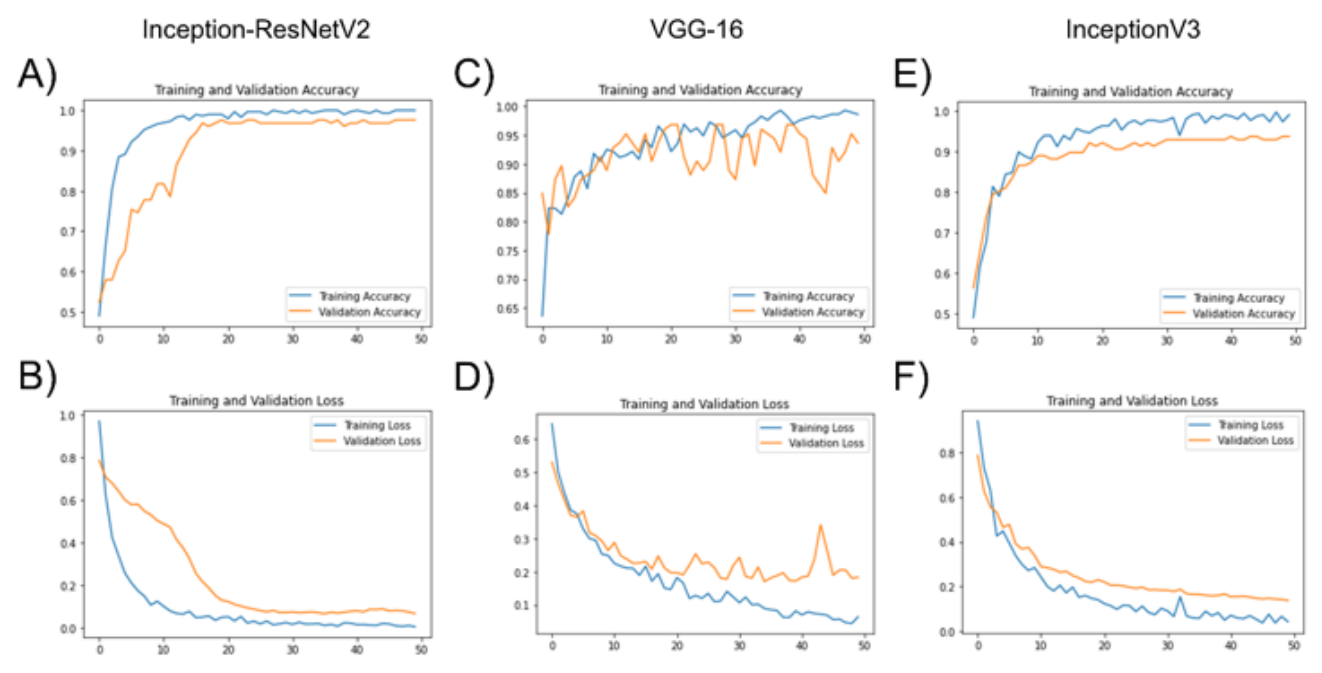
Figure 2. Training/validation accuracy ( A , C , E ) and training/validation loss ( B , D , F ) plots for the fine ‐ tuning for the ImageNet pretrained Inception ‐ ResNetV2 ( A , B ), VGG ‐ 16 ( C , D ), and Inception V3 ( E , F ).